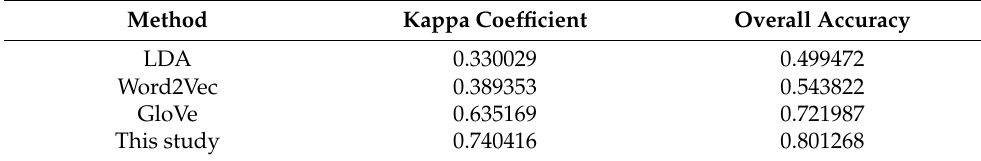
Table 6. Kappa coefficient and overall accuracy.